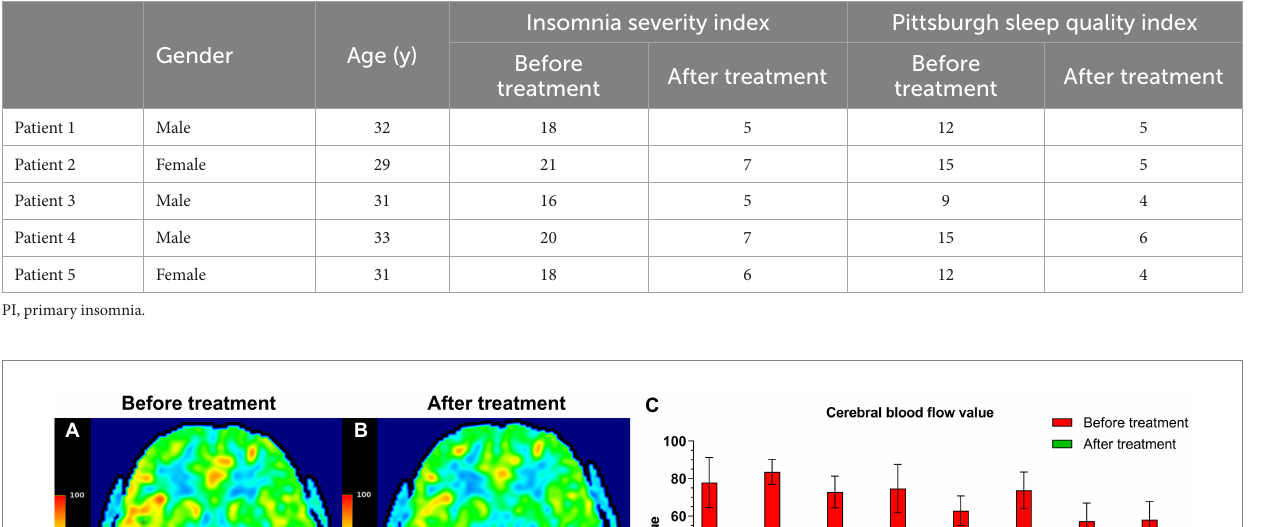
TABLE 3 The clinical data of five PI patients with reexamination.